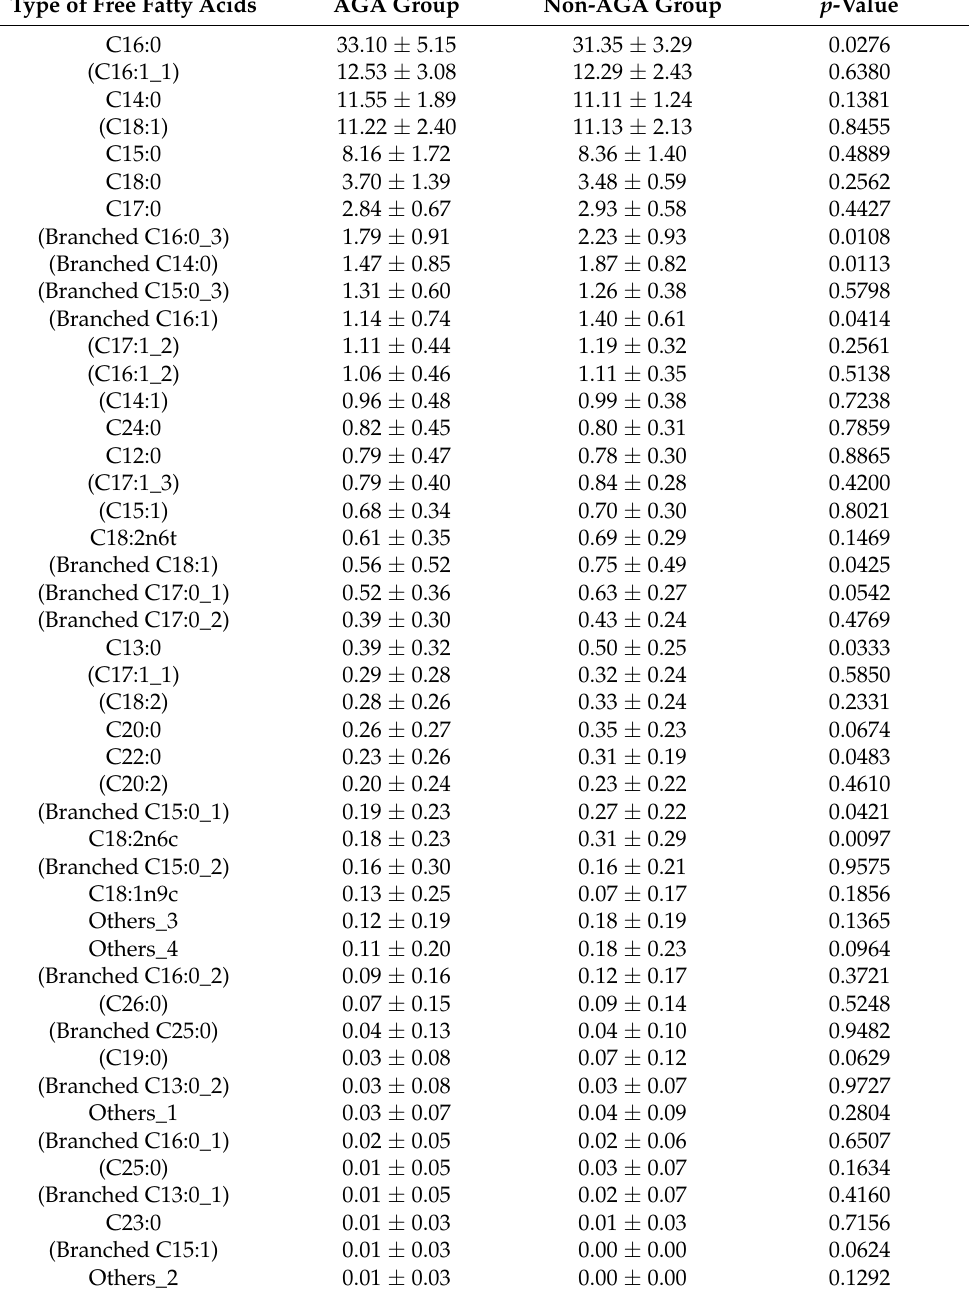
Table 2. Composition (%) of free fatty acids in sebum of the AGA and non-AGA groups. Type of Free Fatty